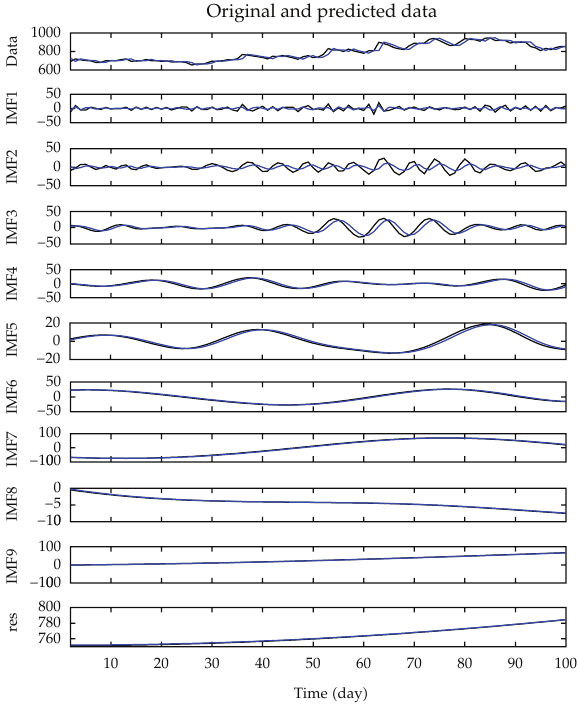
Figure 10: The original financial time series (cid:2) black (cid:3) as well as its IMFs (cid:2) obtained by applying MEMD (cid:3) for channel-2 and the corresponding predicted signals (cid:2) blue (cid:3)